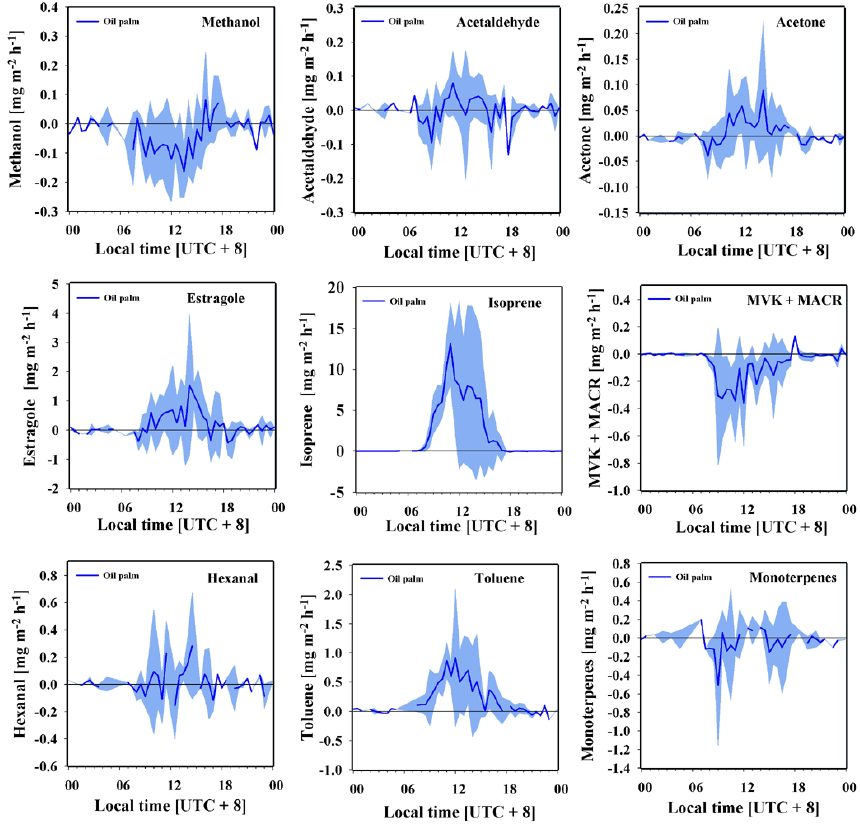
Fig. 5. Average diurnal cycles of VOC fluxes with one standard deviation